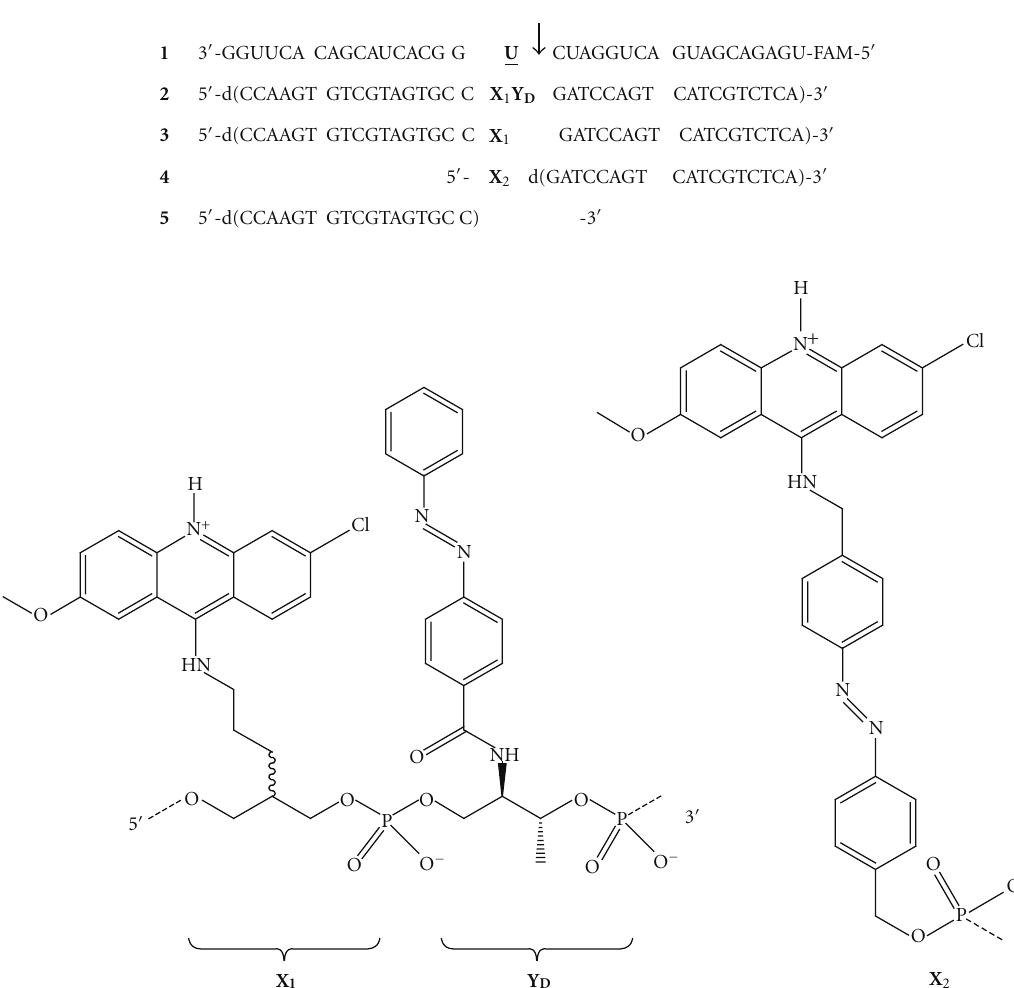
Figure 1: Structures of the substrate RNA ( 1 ) and the modified DNA ( 2 – 4 ). The target phosphodiester linkage (the 5 (cid:2) -phosphate of U-19) is indicated by the